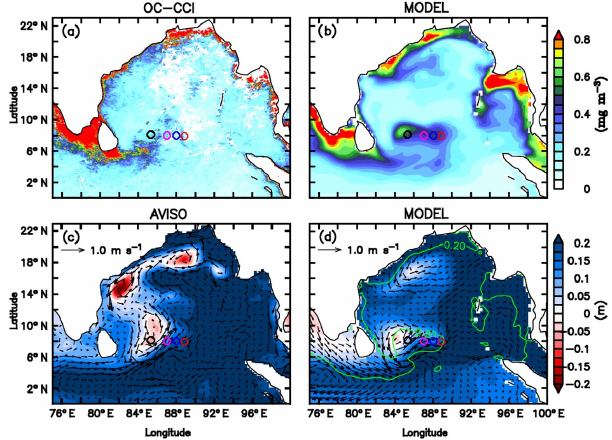
Figure 12. Comparison of the coupled physical–ecosystem model simulation with observations. Monthly mean surface chlorophyll concentrations (mgm − 3 ) for July 2016 from (a) ESA OC-CCI merged product and (b) model. Monthly mean SLAs (m) are over- layed with surface current (ms − 1 ) vectors from (c) AVISO and (d) model. Green contour in panel (d) represents 0.2mmolkg − 1 ni- trate isolines. The glider locations are marked as circles in the study region along 8 ◦ N.